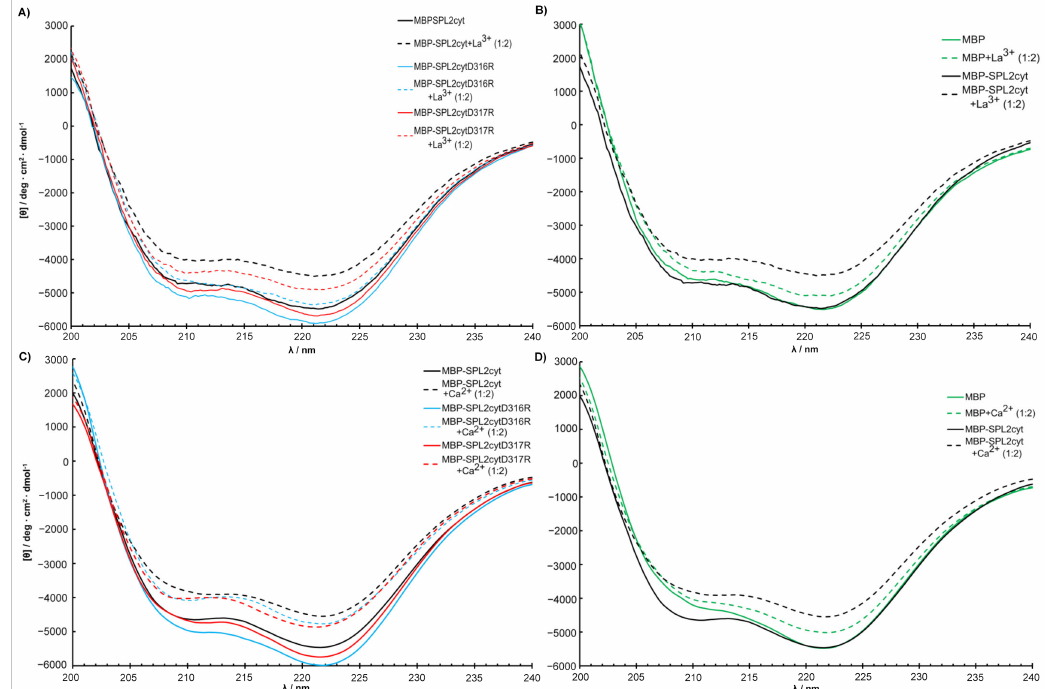
Figure 5. Structural changes in MBP-SPL2cyt and its mutants upon binding of ( A ) La 3+ and ( C ) Ca 2+ measured by CD. ( B , D ) Effects of La 3+ and Ca 2+ , respectively, on the conformation of MBP and MBP-SPL2cyt. For direct comparison of MBP and MBP-SPL2cyt, spectra shown in ( B , D ) were normalized at 220